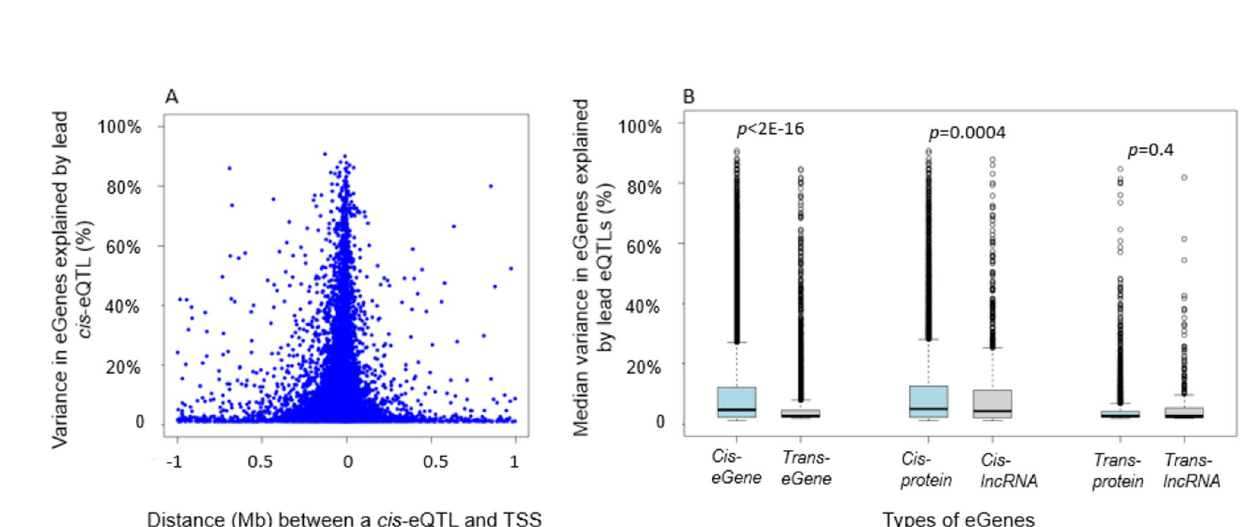
Figure 1. Variance in eGenes explained by lead e-QLT variants. ( A ) Variance in eGenes explained by lead cis - eQTLs in relation to the distance in mega base pairs of the lead cis-eQTLs to the transcription start site (TSS) of the cis -gene. ( B ) Comparison of median variance in the expression levels of eGenes explained by the lead eQTL variants. The median value of variance explained in cis -eGenes was significantly higher than that of trans - eGenes (4.8% versus 2.8%, p < 2e−16). For cis -eGenes, the protein-coding-eGenes had slightly higher median variance explained in the expression level than cis‑ lncRNA genes (5.1% versus 4.3%, p = 0.0004). No significant difference in variance explained in trans‑ eGenes of protein-coding genes versus trans‑ lncRNA genes (2.8% versus 2.7%, p =